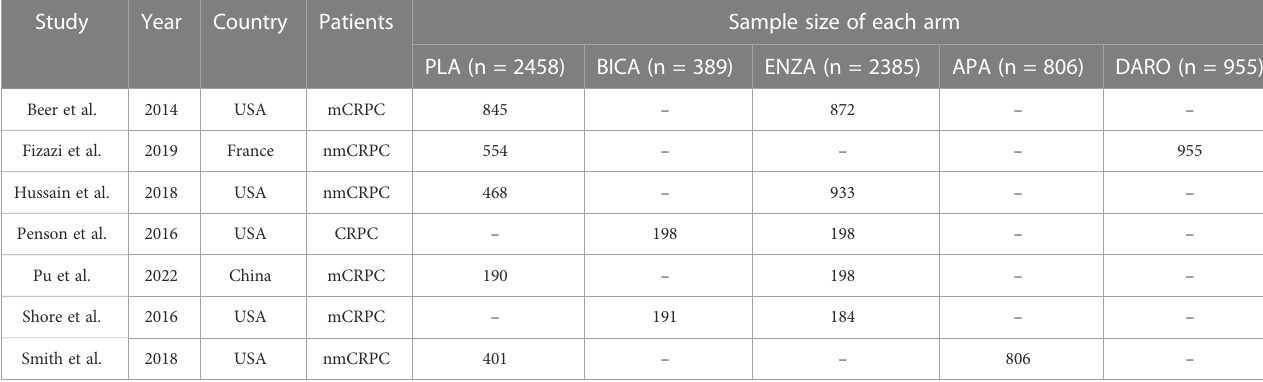
Table 1 Characteristics of included